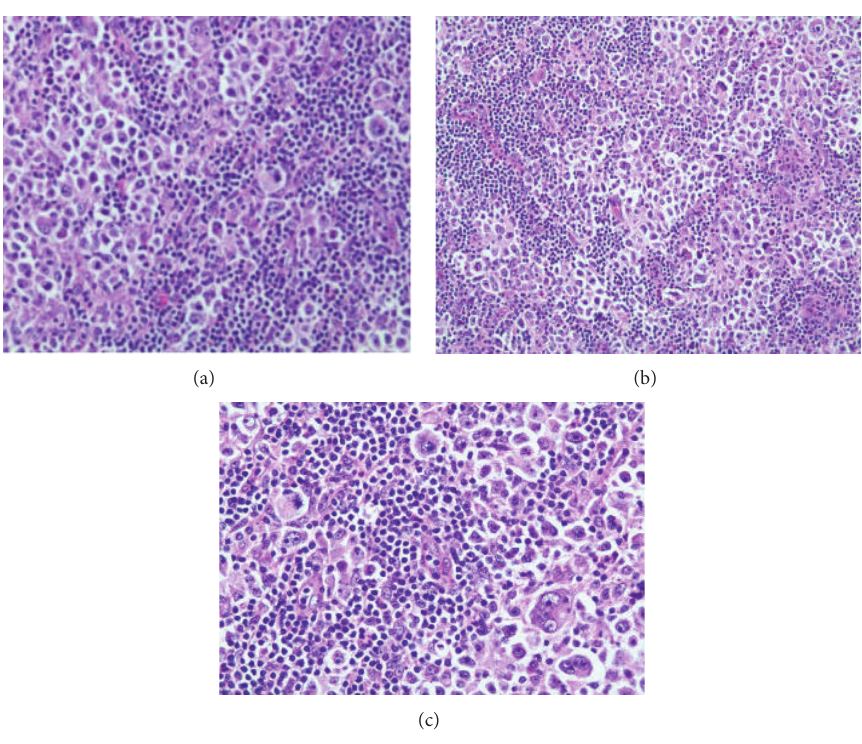
Figure 5: (a, b, c) Hematoxylin & Eosin stain slides showing tumor characteristic.